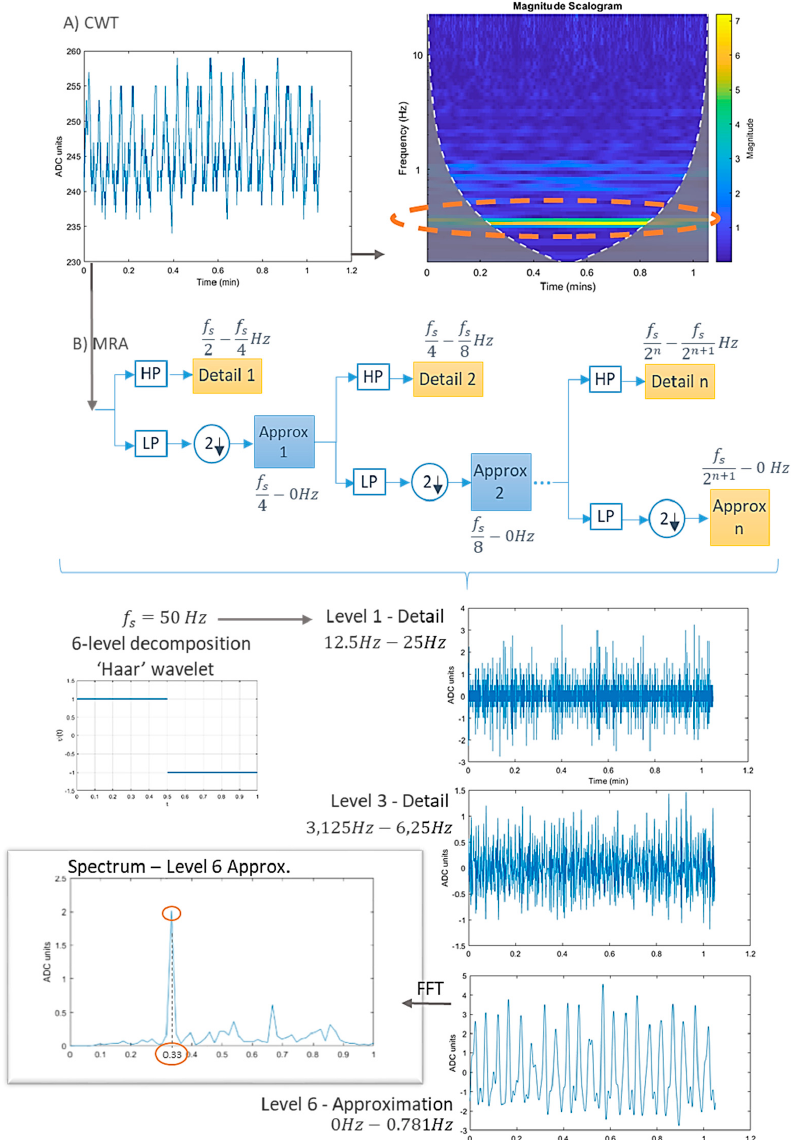
Figure 32. Wavelet transform. ( A ) 2D representation of the continuous wavelet transform (CWT) ( right ) of an example signal ( left ) taken from a dataset of real respiration signals [254] (RR of 20 bpm − 0.33 Hz-, and sampling frequency of 50 Hz). ( B ) Multiresolution analysis (MRA) decomposition process ( top ). The lower part shows an example of the MRA analysis applied to the signal above (( A ), left ). Six-level decomposition was applied using the ‘Haar’ wavelet. Two detail levels and the sixth approximation level are represented. The spectrum of the approximation coefficients (level 6) was obtained.